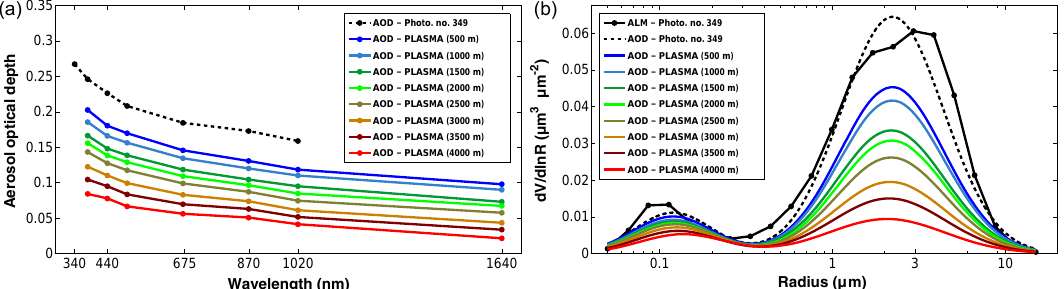
Figure 14. Aerosol optical depth values measured by PLASMA airborne photometer at different height levels in the take-off from Minorca airport on the 17 June 2013 (11:45) on the left, and the corresponding particle size distribution retrieved by GRASP-AOD inversion on the right. The mean values of the three τ a data measured by the sun photometer at AERONET site Cap d’en Font during the PLASMA profile are also represented with its corresponding GRASP-AOD inversion. The size distribution from the closest AERONET standard inversion (09:00) is also represented in the figure as a